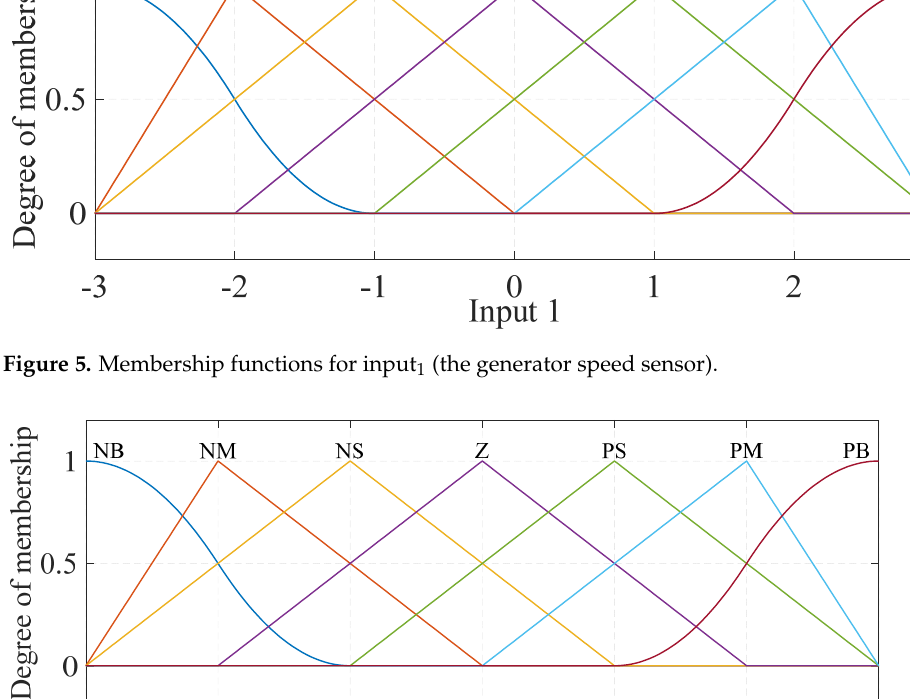
Figure 5. Membership functions for input 1 (the generator speed sensor). Table 3. Membership function, fuzzy set labels, and fuzzy numbers representation for Figure 5.